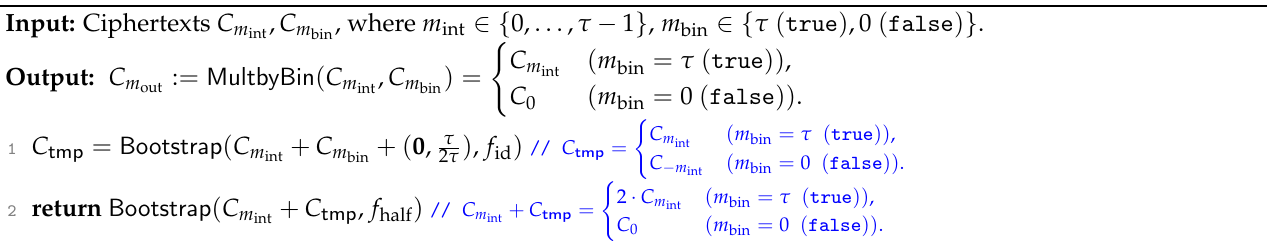
Algorithm 8: MultbyBin ( C m